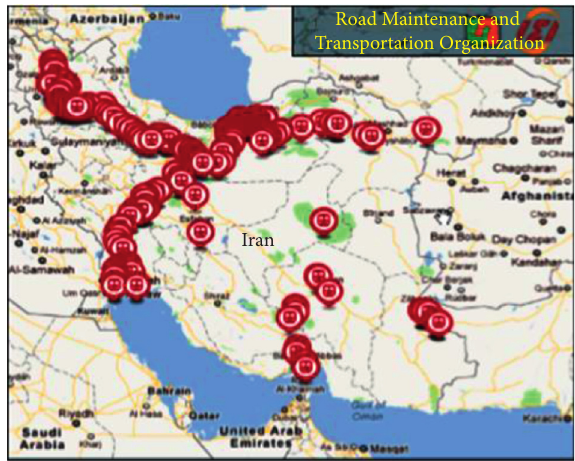
Figure 7: Location of industrial